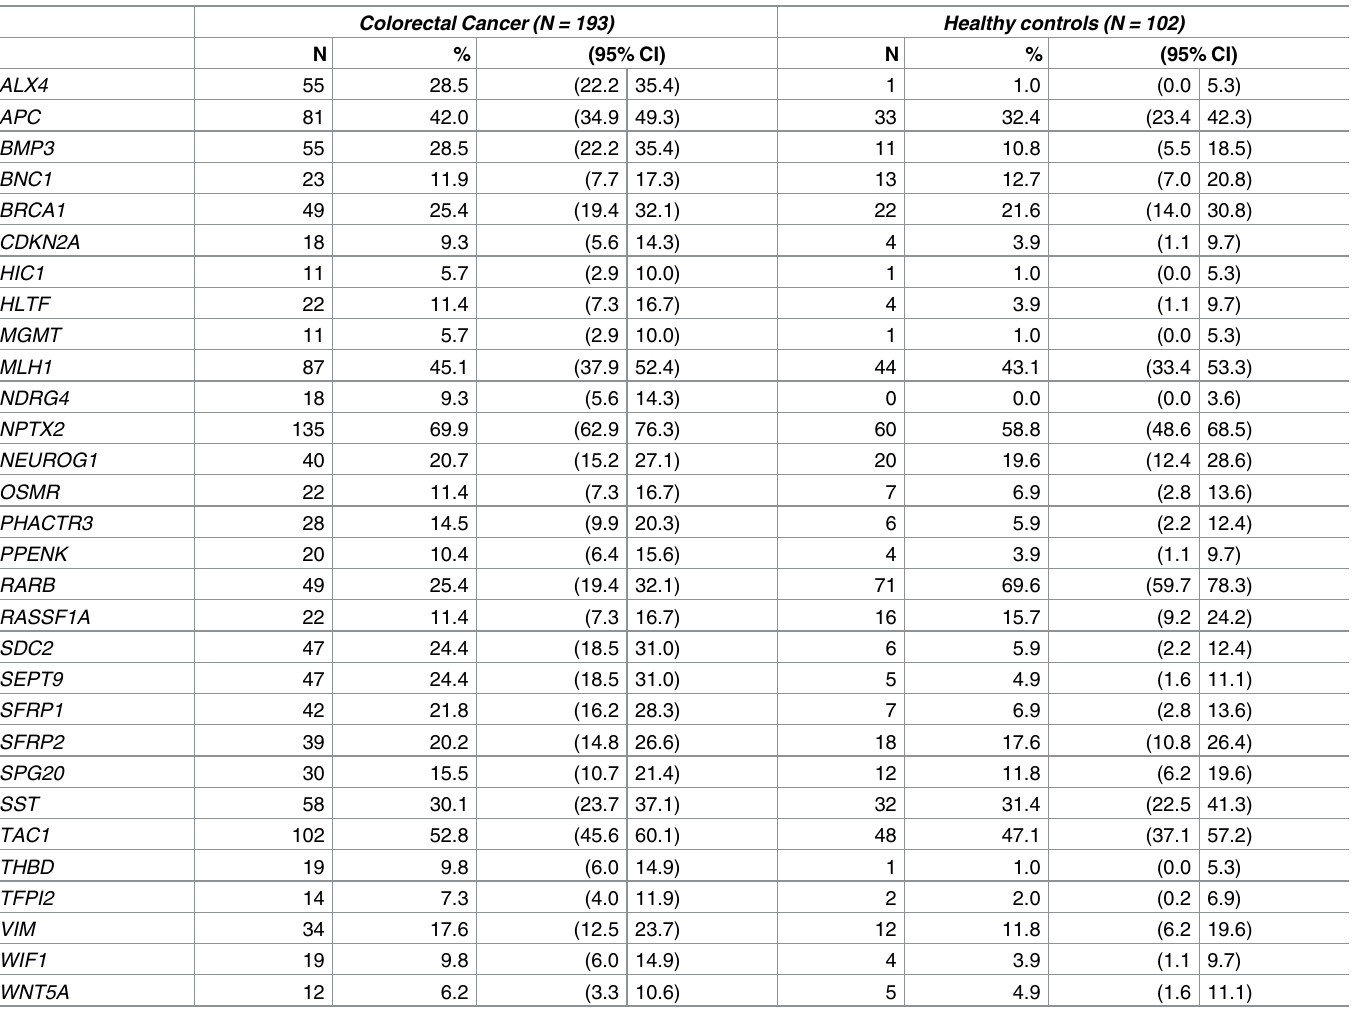
Table 2. Hypermethylation status according to gene